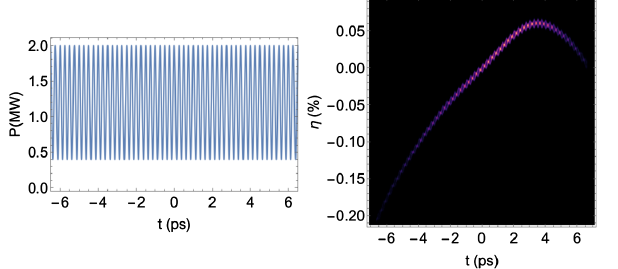
FIG. 8. Left: Laser heater modulation. Right: longitudinal phase space at laser heater exit.